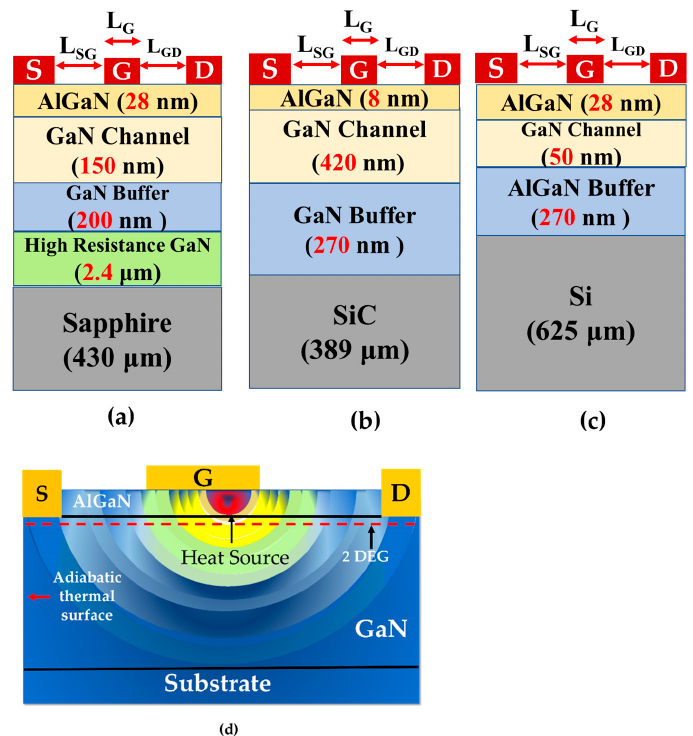
Figure 1. Cross-sectional diagram of AlGaN/GaN HEMT on sapphire ( a ), SiC ( b ), and Si ( c ), with a highly localized heat source under the gate ( d ). Thermal Resistance Model